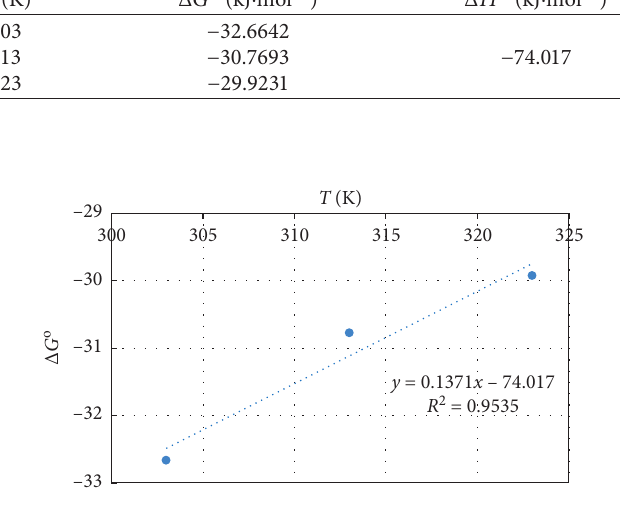
Figure 11: Adsorption kinetics of MB adsorption process using YPS. (a) First-order reaction model. (b) Pseudo-first-order reaction model. (c) Second-order reaction model. (d) Pseudo-second-order reaction model. Table 17: Thermodynamic parameters of MB adsorption process by the YPS2 sample. Adsorbent